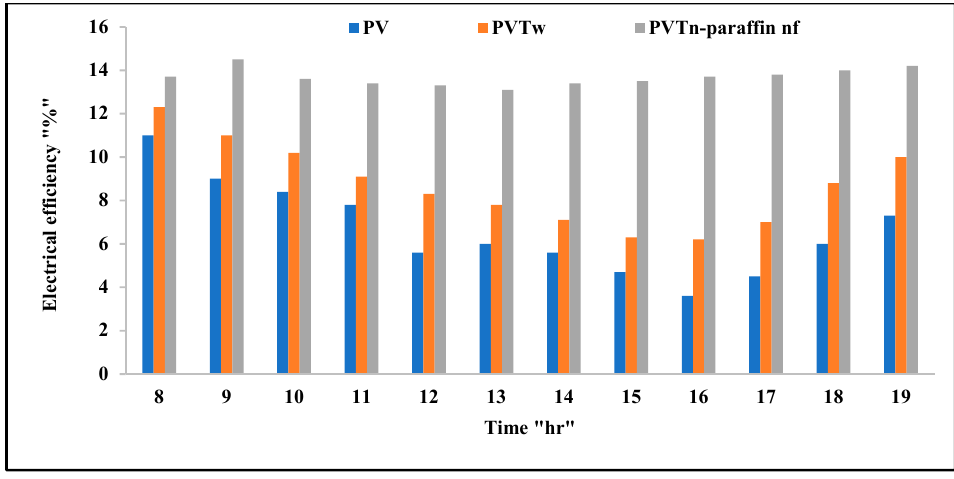
Figure 8. The electrical efficiencies of the tested systems variations with time.